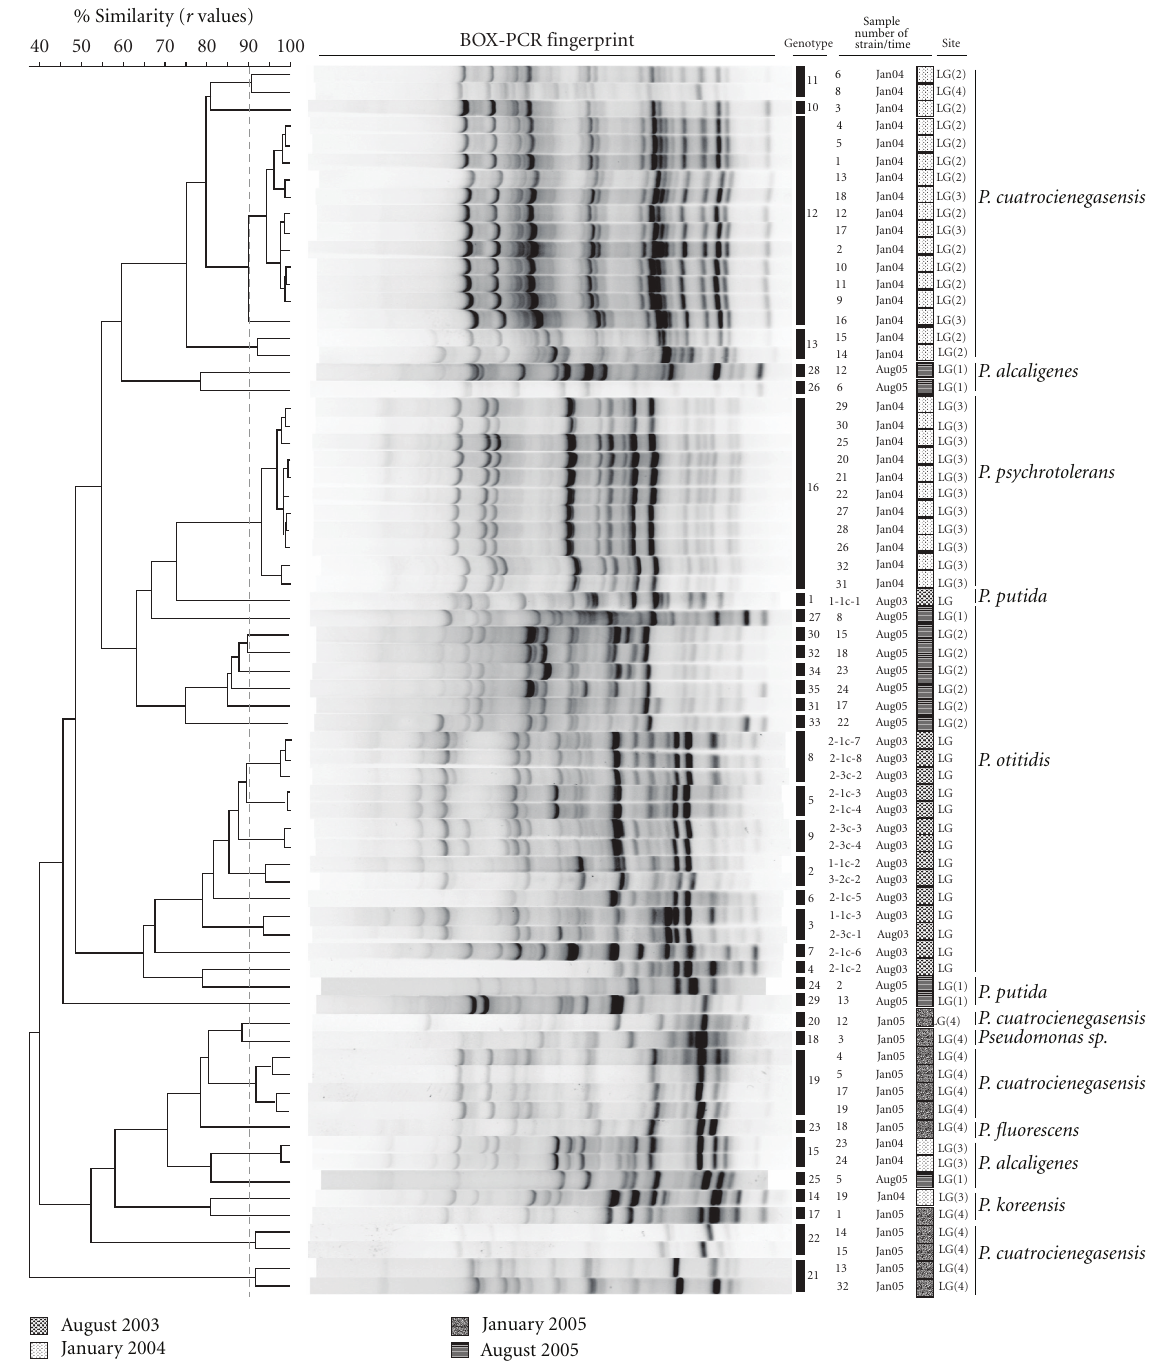
Figure 2: Pseudomonas isolates cluster analysis of genetic similarity. BOX-PCR genomic fingerprints of individual isolates were analyzed and grouped using product-moment UPGMA algorithm. A similarity value ( r ) of 90% was used to determine the same genotypes (dashed line).